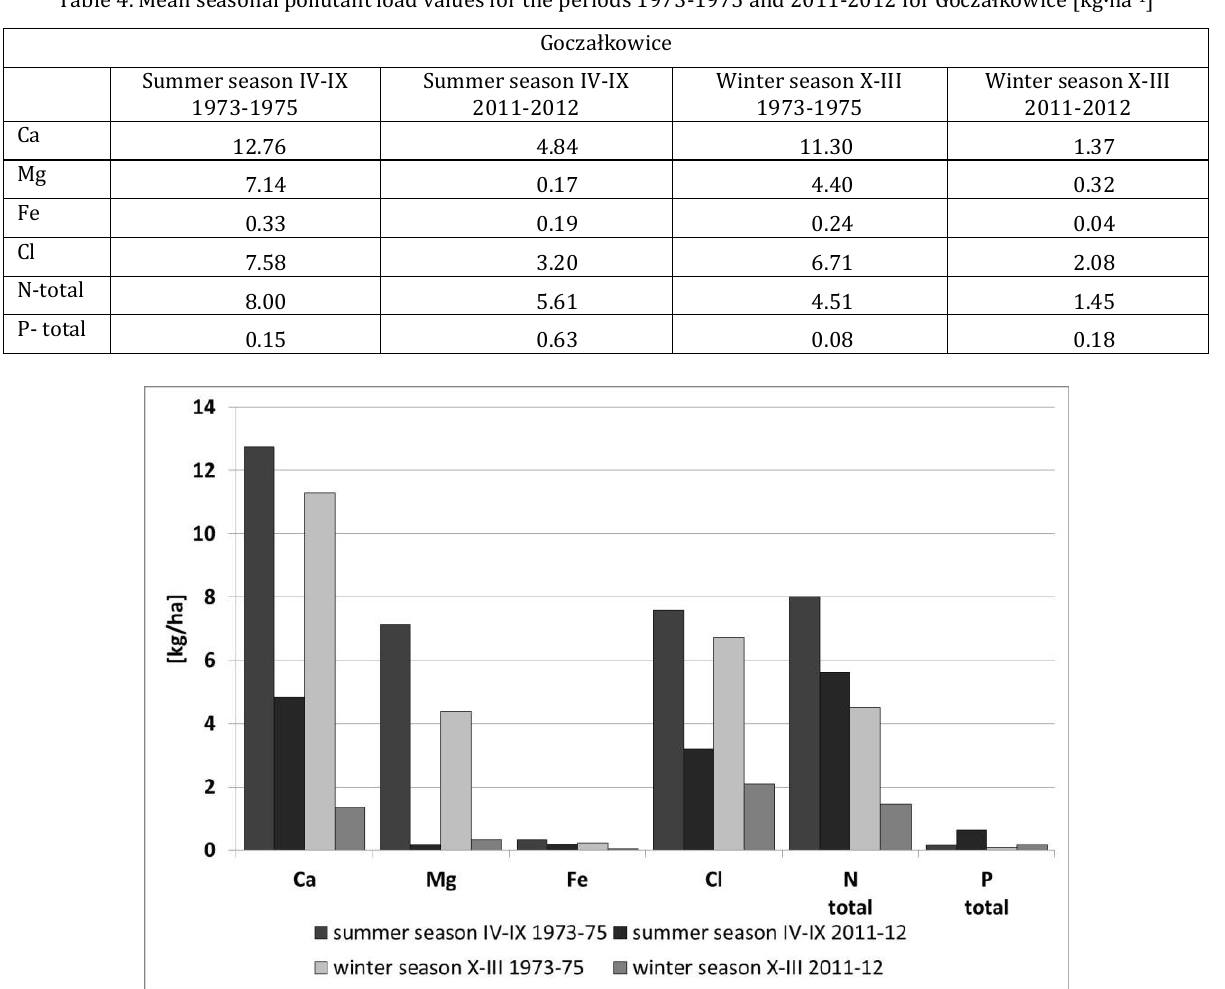
Fig. 10. Mean wet deposition values for seasons in the periods 1973-75 and 2011-12 Goczałkowice [kg·ha -1